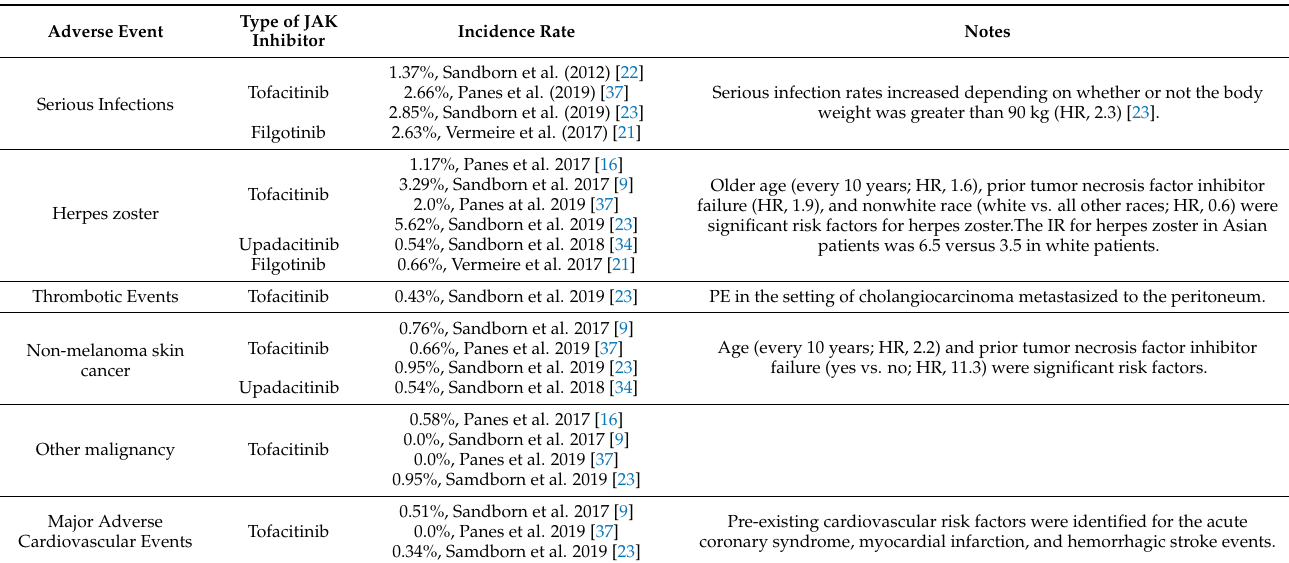
Table 3. Adverse events reported in JAK